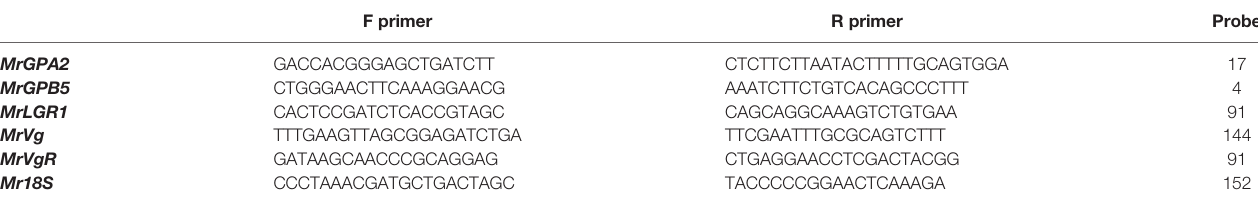
TABLE 2 | Primers and probes from Roche probe library used for